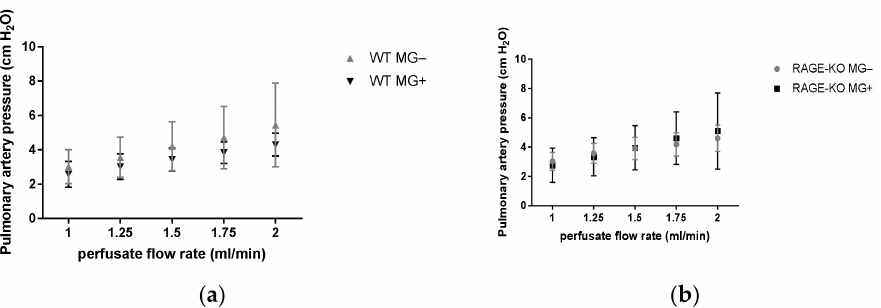
Figure 2. Pulmonary artery pressure measurement in isolated lungs in an increased perfusion flow rate at 1.00, 1.25, 1.50, 1.75, and 2.00 mL/min measured in mice supplemented for 12 months with Methylglyoxal (MG). No significant differences between fed ( a ) wild type (WT) and ( b ) RAGE knockout (RAGE-KO) and controls were observed. Data are shown as mean SD ( n = 10 each genotype, group, and time point). Means were statistically compared by two-way ANOVA followed by Sidak’s multiple comparison test.